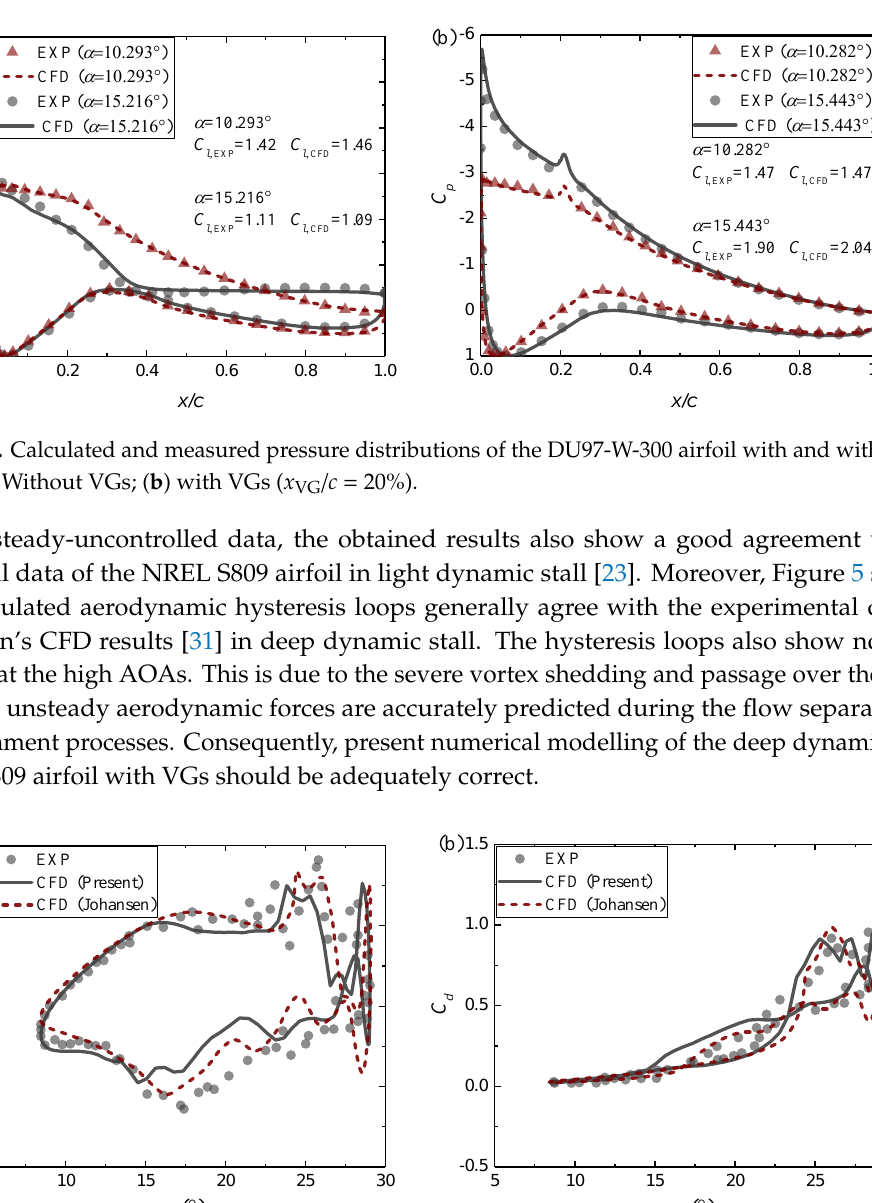
Figure 5. C l - α and C d - α hysteresis loops of the NREL S809 airfoil undergoing deep dynamic stall ( α m = 18.75°, A = 10.3°, and k = 0.078). ( a ) C l ; ( b ) C d .